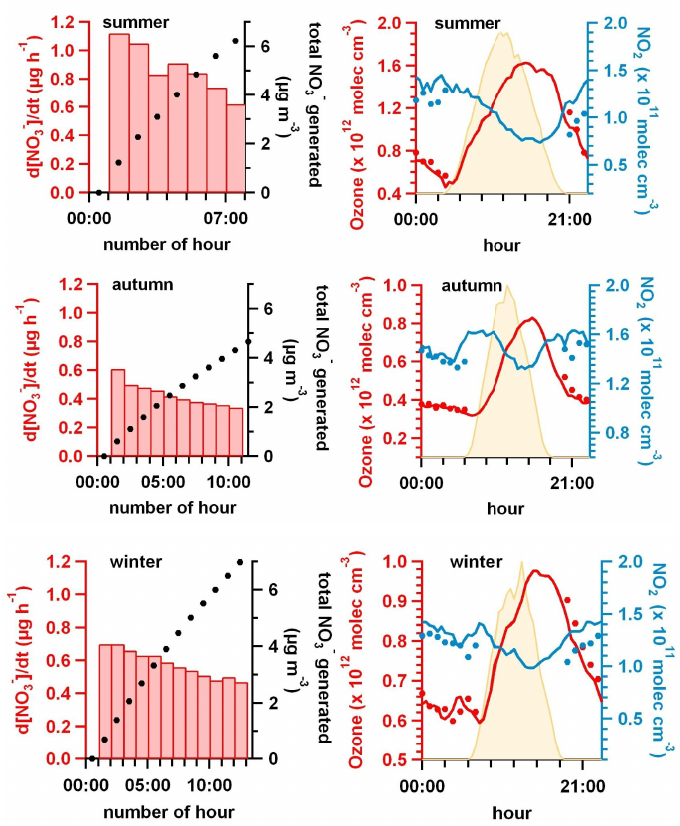
Fig. 9. Maximum nitrate formation rate and concentration expected from nighttime chemistry simulation for each season (left) and the comparison between the measured (line) and the simulated (dots) ozone and NO 2 concentrations (right). The colored surface area on the right side corresponds to the solar radiation and can be used to distinguish nighttime from daytime